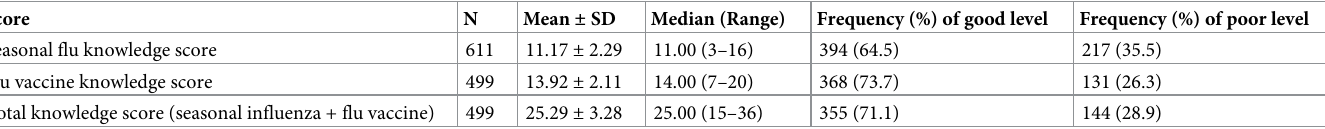
Table 4. Participants’ knowledge score.